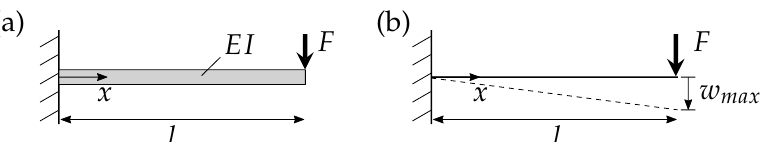
Figure 12. A point load F is applied to a cantilever beam of a length l and a bending stiffness EI ( a ). The beam deflects as shown with a dashed ine in ( b ) leading to a maximum deflection w max . The sketches are based on [24].